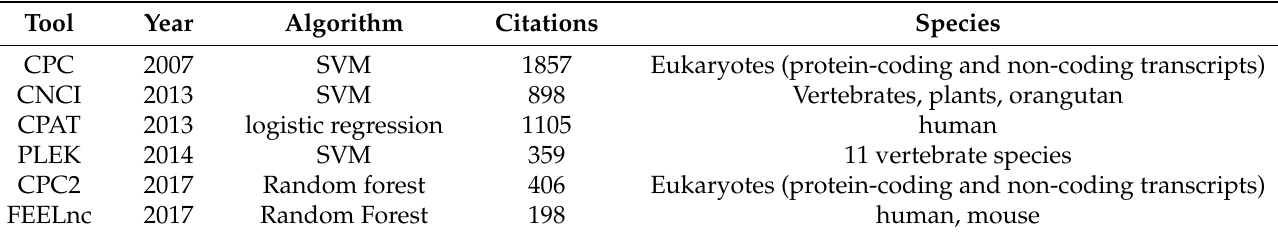
Table 2. Tools with the highest impact on lncRNA annotation research ordered by year. A tool was considered to be of high impact if it had accumulated a significantly larger number of citations in the same time frame than a competing tool and could be shown to be involved in the identification of multiple bona fide non-coding RNAs that were previously undiscovered. Number of citations refers to the last access on 11 November